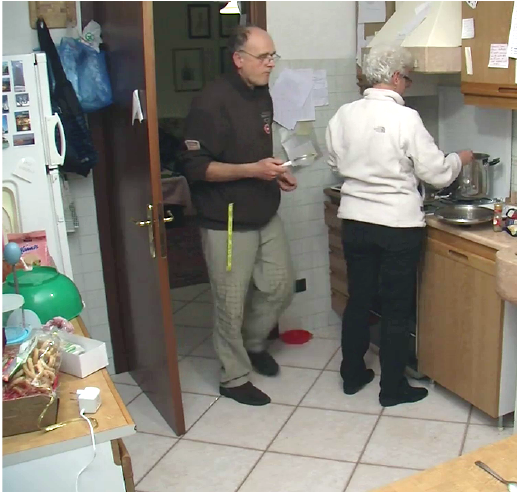
Figure 4. Extract (1) line 3. Dad walks back to the kitchen threshold while initiating repair